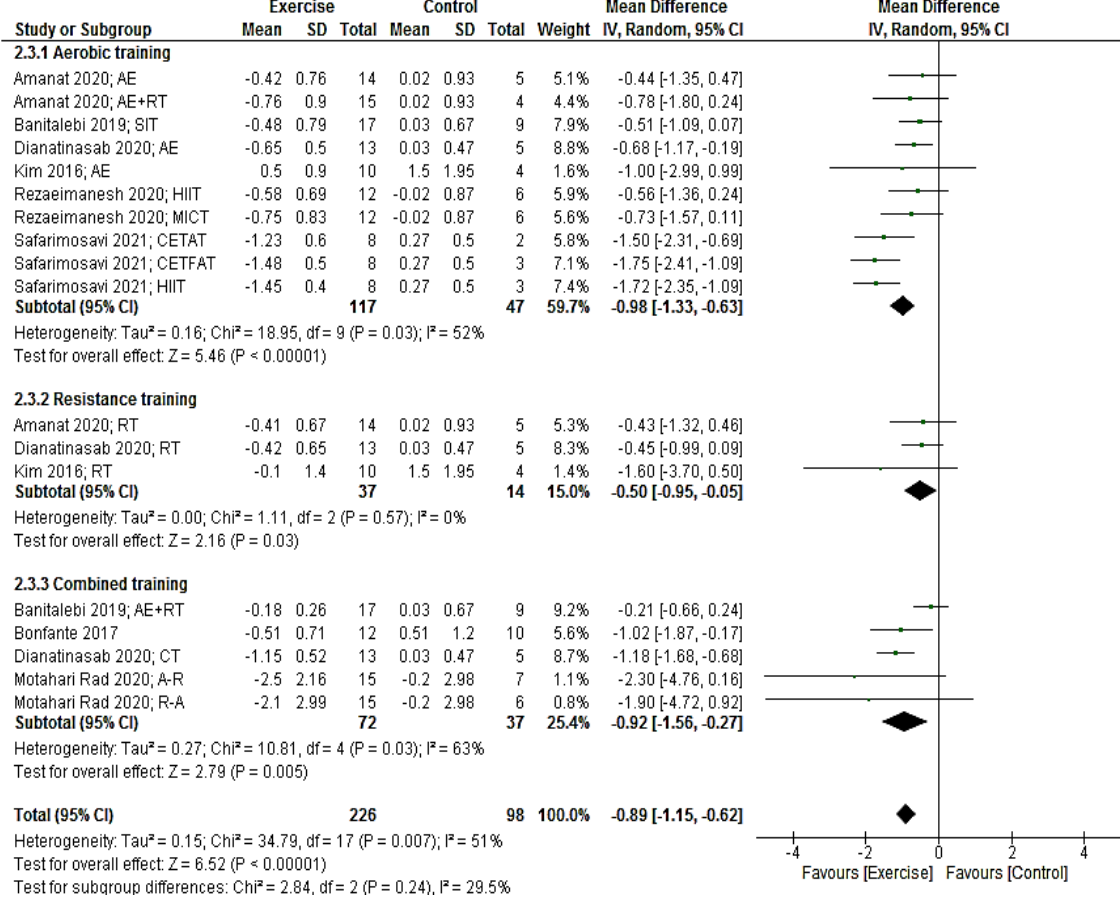
Figure 5: Forest plot of the effects of exercise training versus control on HOMA-IR. AE, aerobic; RT, resistance training; SIT, sprint interval training; HIIT. High intensity interval training; CETFAT, continu- ous endurance training with intensity equivalent to Fatmax (maximal fat oxidation); CETAT, continuous endurance training with intensity equivalent to anaerobic